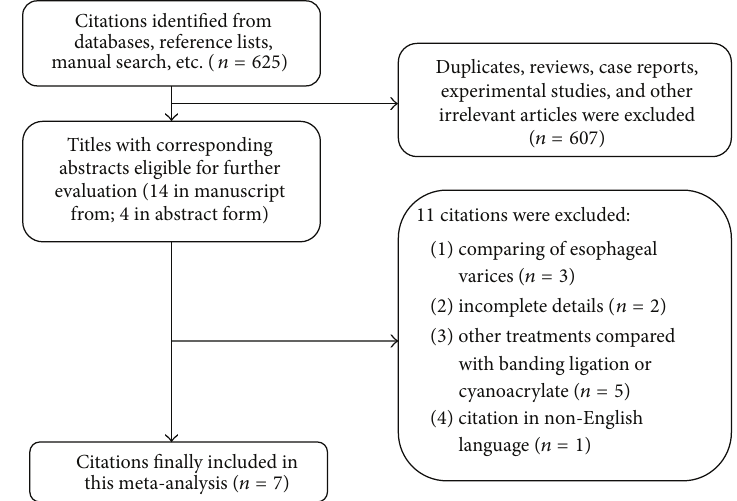
Figure 1: Flow chart of the study selection.